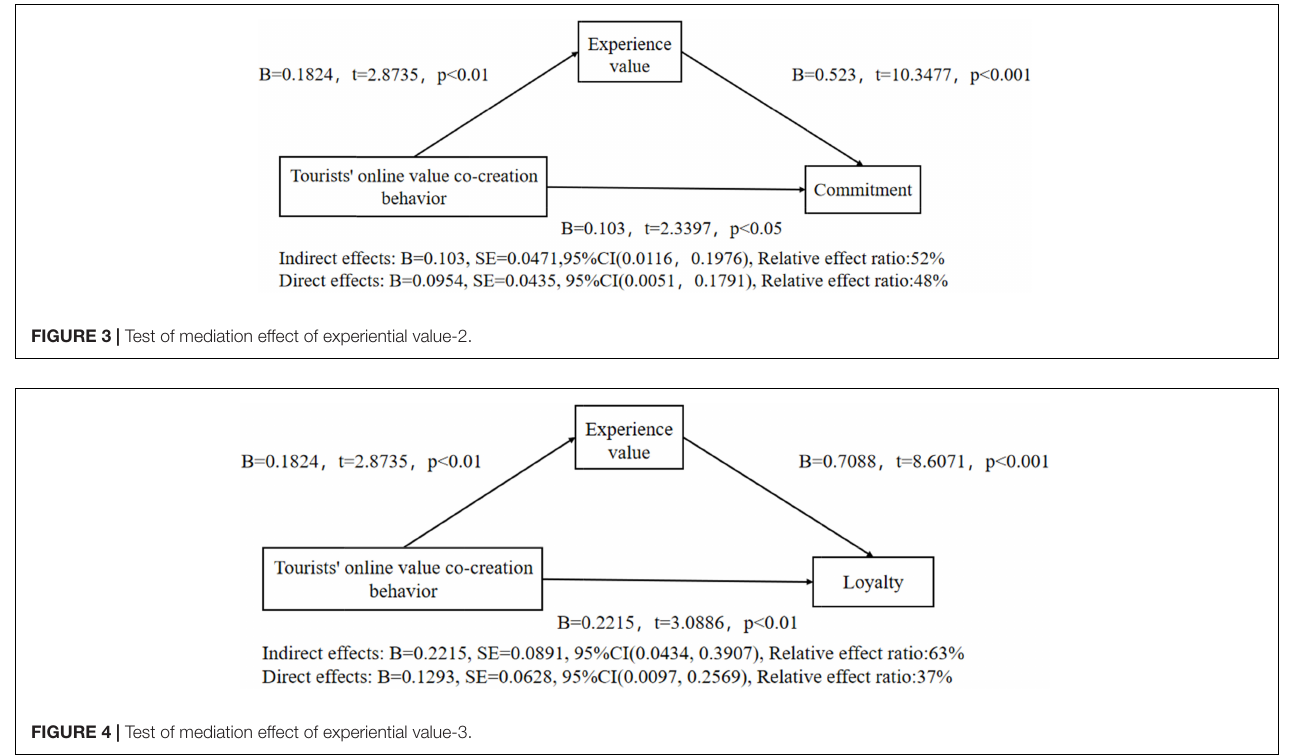
FIGURE 4 | Test of mediation effect of experiential value-3.